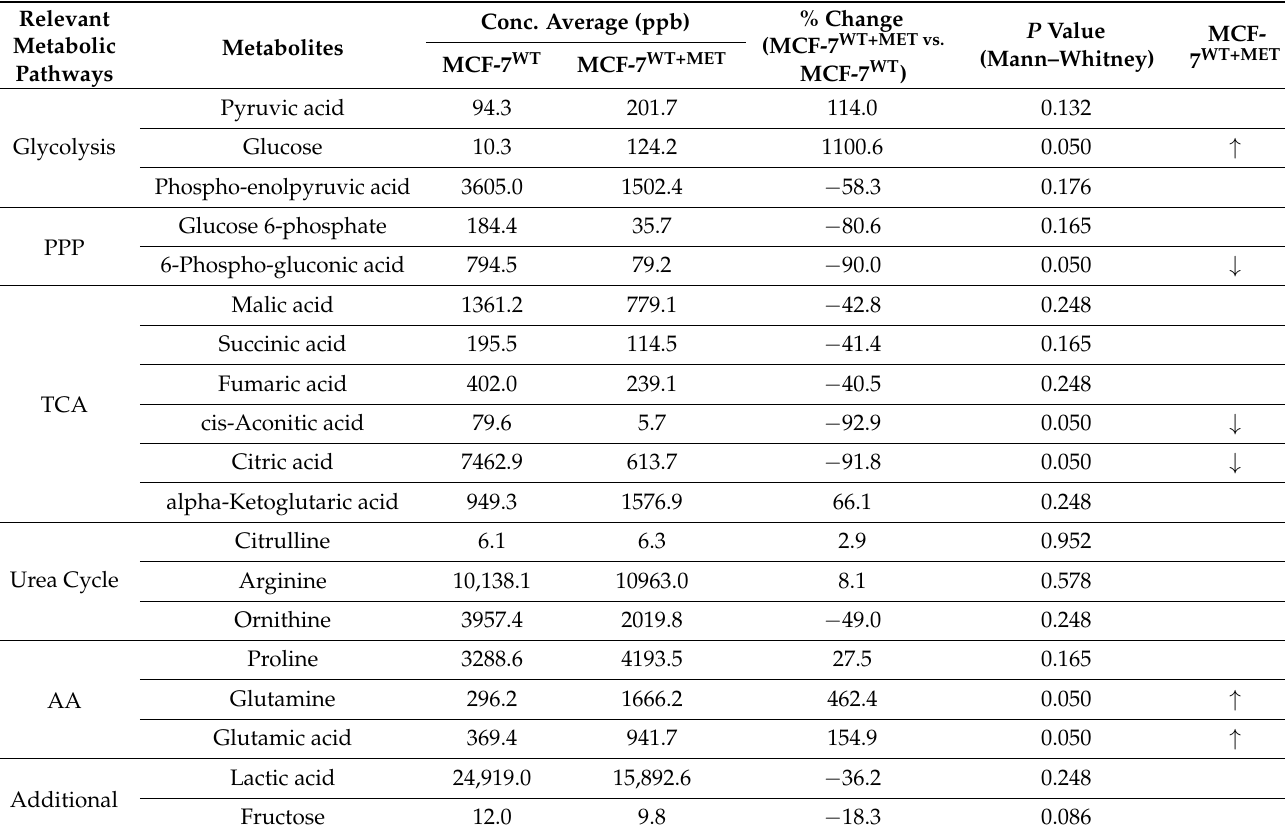
Table 5. Targeted metabolic profiles of some metabolites of glycolysis, pentose phosphate pathway, TCA and urea cycles in MET treated wild type MCF-7 cells (MCF-7 WT+MET ) and in MCF-7 WT cells cultured in medium containing Gln. AA—amino acids, PPP—pentose phosphate pathway, TCA—tricarboxylic acids cycle. ↑ —significant increase in the concentration